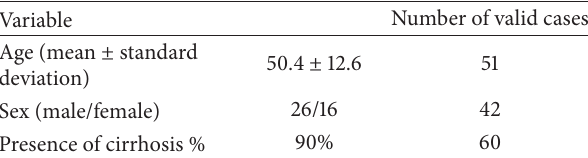
Table 1: Demographic information of the study